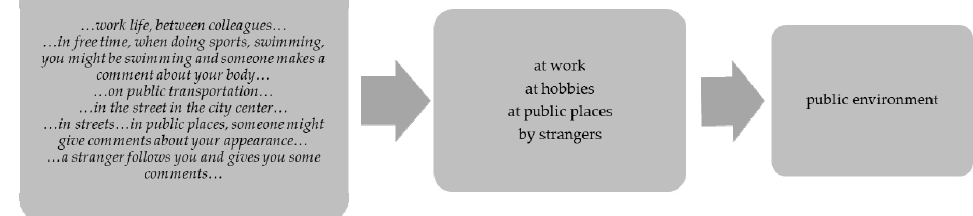
Figure 1. Example of how categories were emerged.